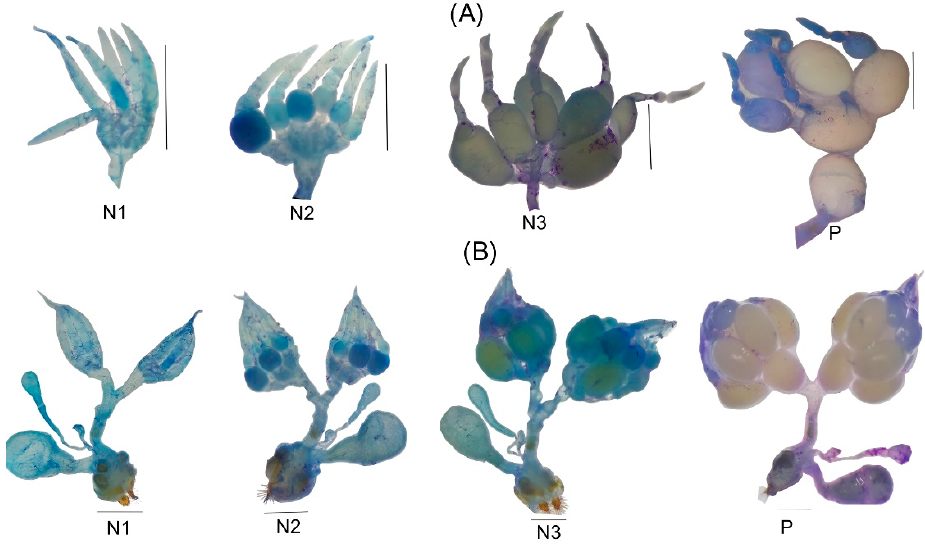
Figure 10. Ovarian development of Cyclocephala barrerai female. ( A ) individual ovariole maturation, ( B ) ovary maturation N1 = nulliparous 1, N2 = nulliparous 2, N3 = nulliparous 3, P = parous. Bars = 2 mm.